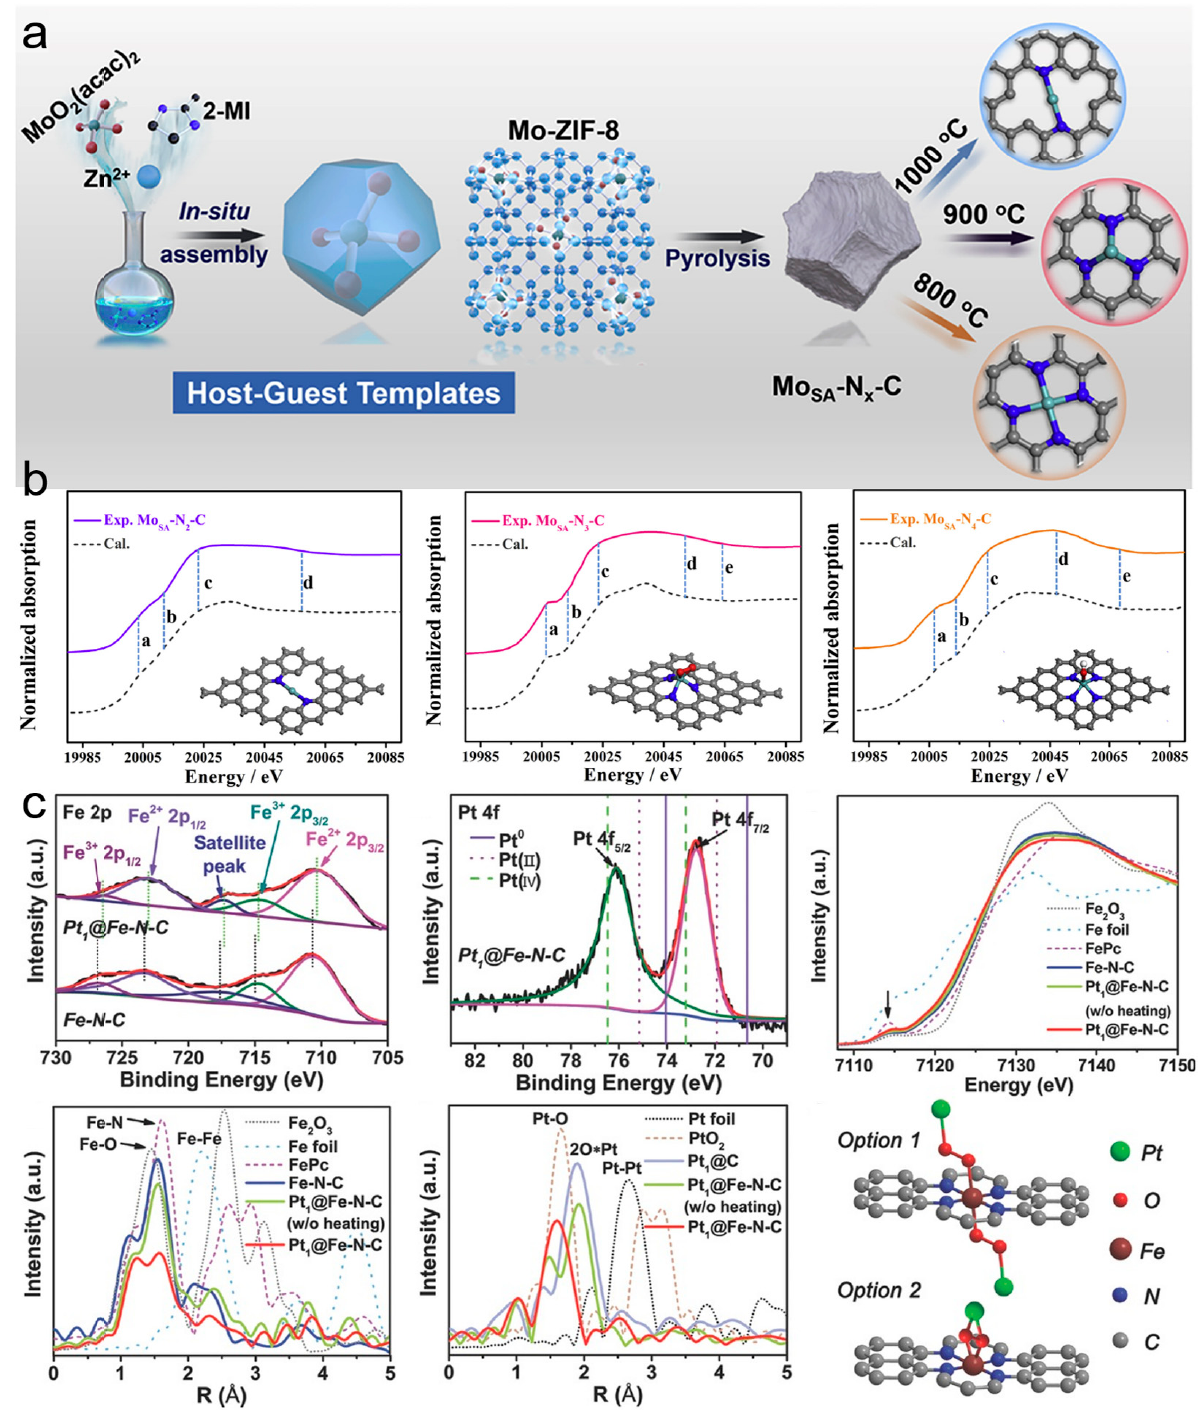
Figure 11. ( a ) Schematic illustration of the synthesis of Mo SA –N x –C catalysts with different Mo–N coordination numbers. ( b ) XANES spectra of Mo SA –N x –C catalysts in experimental and theoretical calculation. Reproduced with permission of [107], copyright 2022 Cell Press. ( c ) Surface composition and valence state of Pt 1 @Fe–N–C and Fe–N–C. Reproduced with permission of [108], copyright 2018 John Wiley and